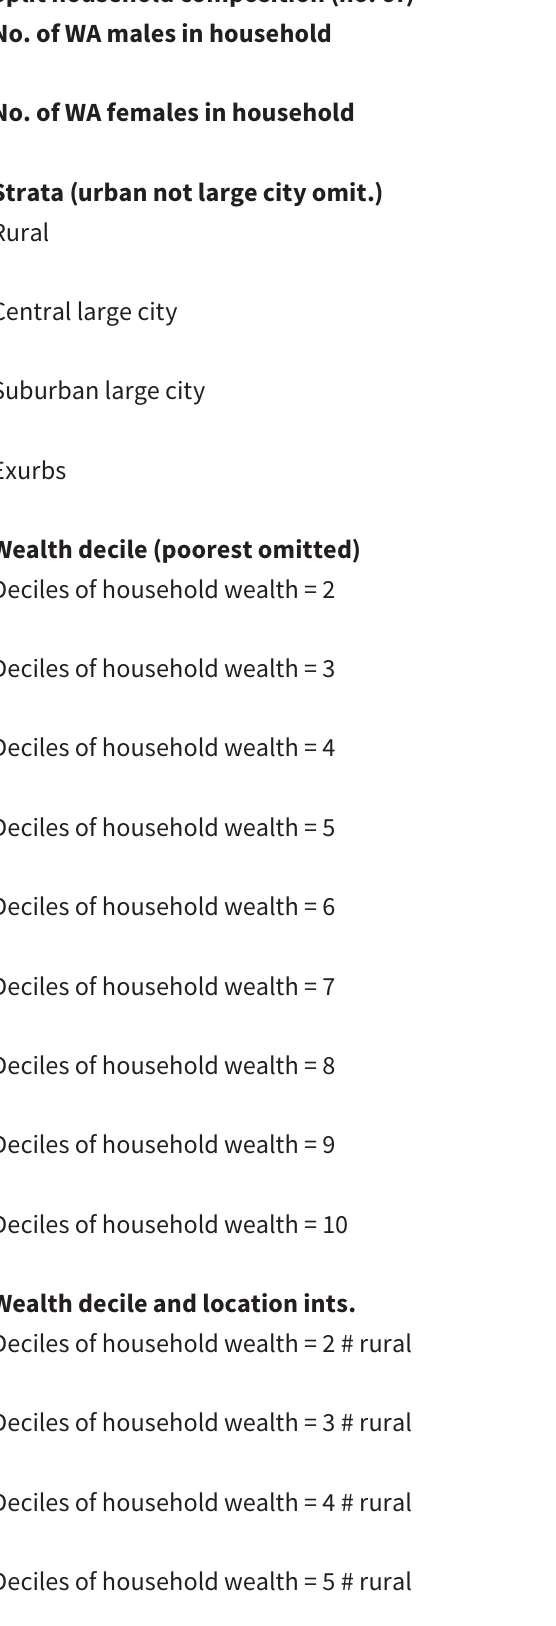
Type II attrition logit model: Probability split household attrited. Split household composition (no.